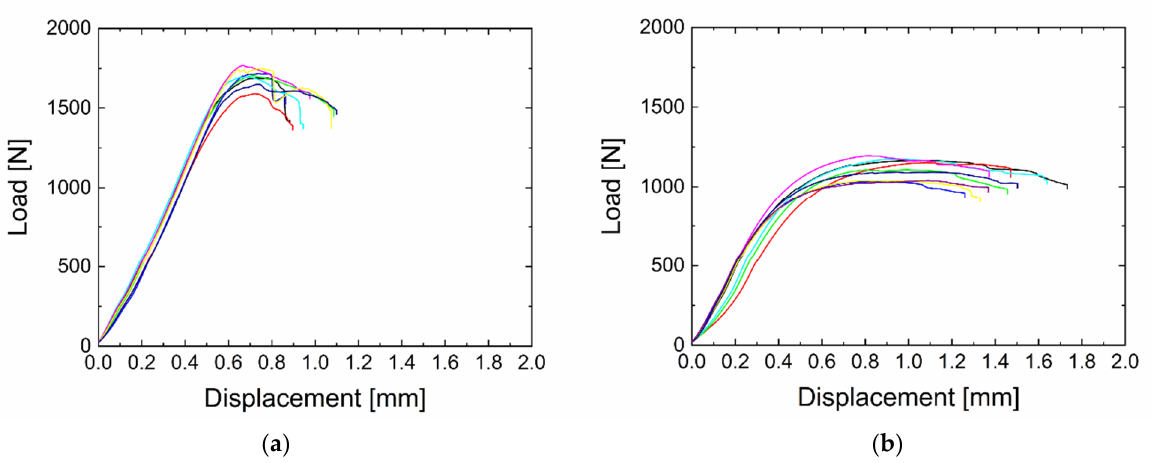
Figure 2. Load vs. displacement curves obtained by the short beam shear test (SBST) for a glass fibre (GF)/polyester composite with plasma-coated GFs at 33% oxygen in the tetravinylsilane (TVS)/O 2 mixture and at a power of ( a ) 2 W and ( b ) 30 W.